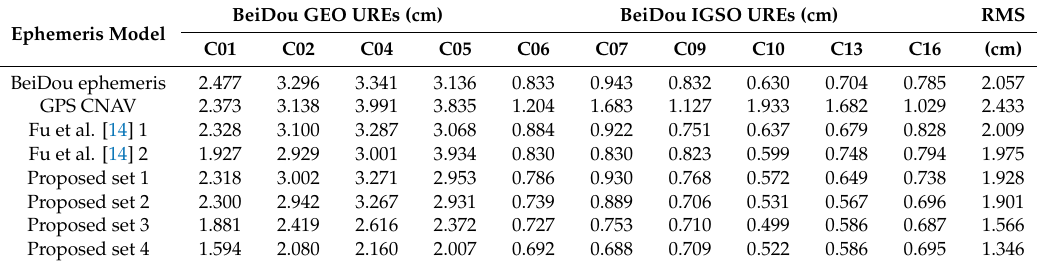
Table 7. UREs and their RMS values for di ff erence ephemeris